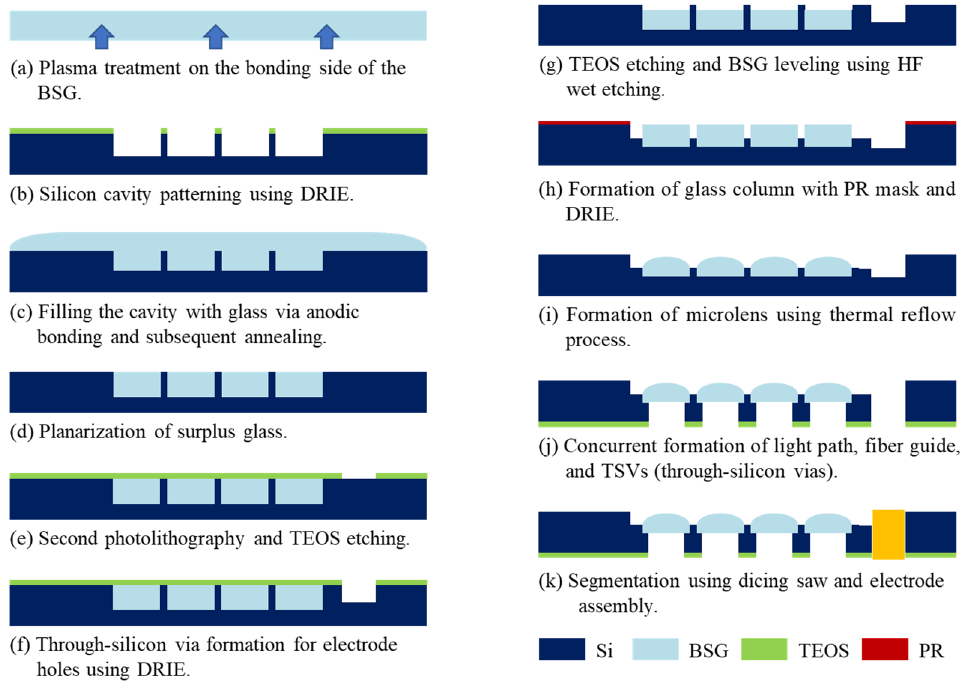
Figure 1. The fabrication process of the microlens array (MLA) and through-silicon vias (TSVs).